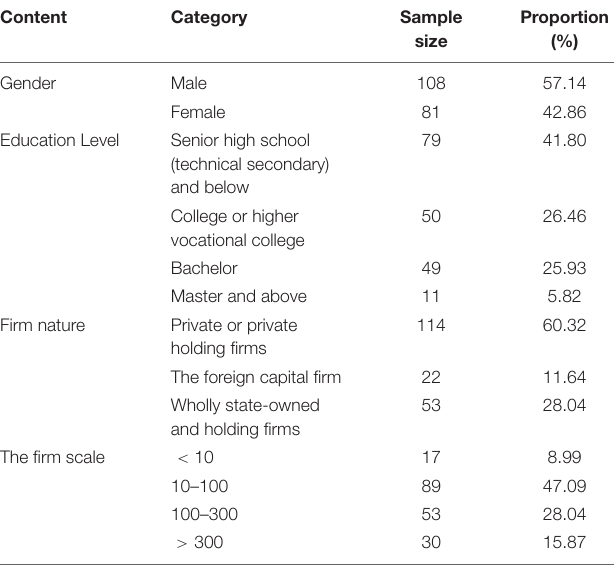
TABLE 1 | Results of descriptive statistics of the sample ( N = 189).